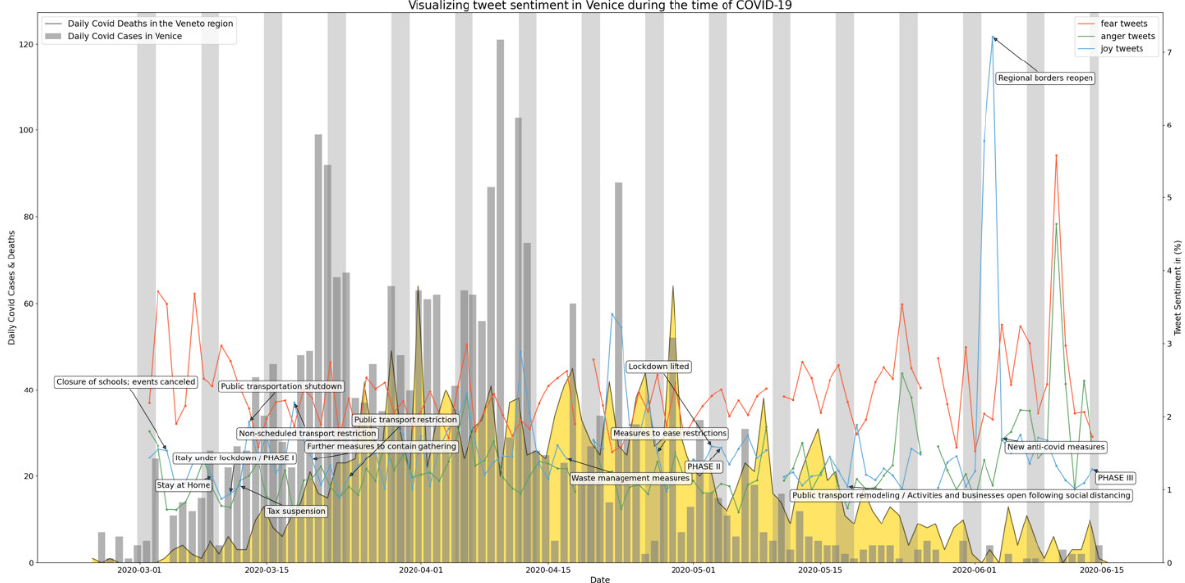
Figure A2. Visualizing Twitter sentiment in Venice during the time of COVID-19. Users on Twitter produced the highest number of tweets related to fear in the month of June with 2.56% of the total collected tweets when compared to March with 2.35%, April with 2.15%, and May with 2.39%, respectively. Venice Twitter users displayed a total average of 2.31% tweet frequency expressing fear. Fear may reflect the beginning of Phase II, which eased many of the measures intended to contain the virus spread. The number of daily new COVID-19 cases and daily fatalities for the Veneto region significantly dropped since the month of May and continued to drop in Phase III. The total number of tweets related to fear increased during the end of Phase II (May), which could be related to the re-opening of public transportation services, businesses, Veneto’s regional border, and new added social distance measures related to anti-COVID-19 policy measures (1 m distance). Second, the highest number of tweets expressing anger was found in the month of June (1.82%), compared to the lowest occurrence of angry tweets in the months of April (1.29%), May (1.28%), and March (1.08%), respectively. Venice Twitter users displayed a total average of 1.22% tweet frequency expressing anger. The highest number of tweets related to anger was at the end of Phase II during the public transport remodeling, opening of activities and businesses following social distance measures, and the opening of Veneto’s regional borders. The Veneto region is located in close proximity to the Lombardy region where the BLM international protest occurred. As a result, the Veneto region could be highly influenced by the Lombardy region; thus, the total high peak number of angry tweets displayed (red) in Venice could be related to the BLM protest which took place between 5 and 7